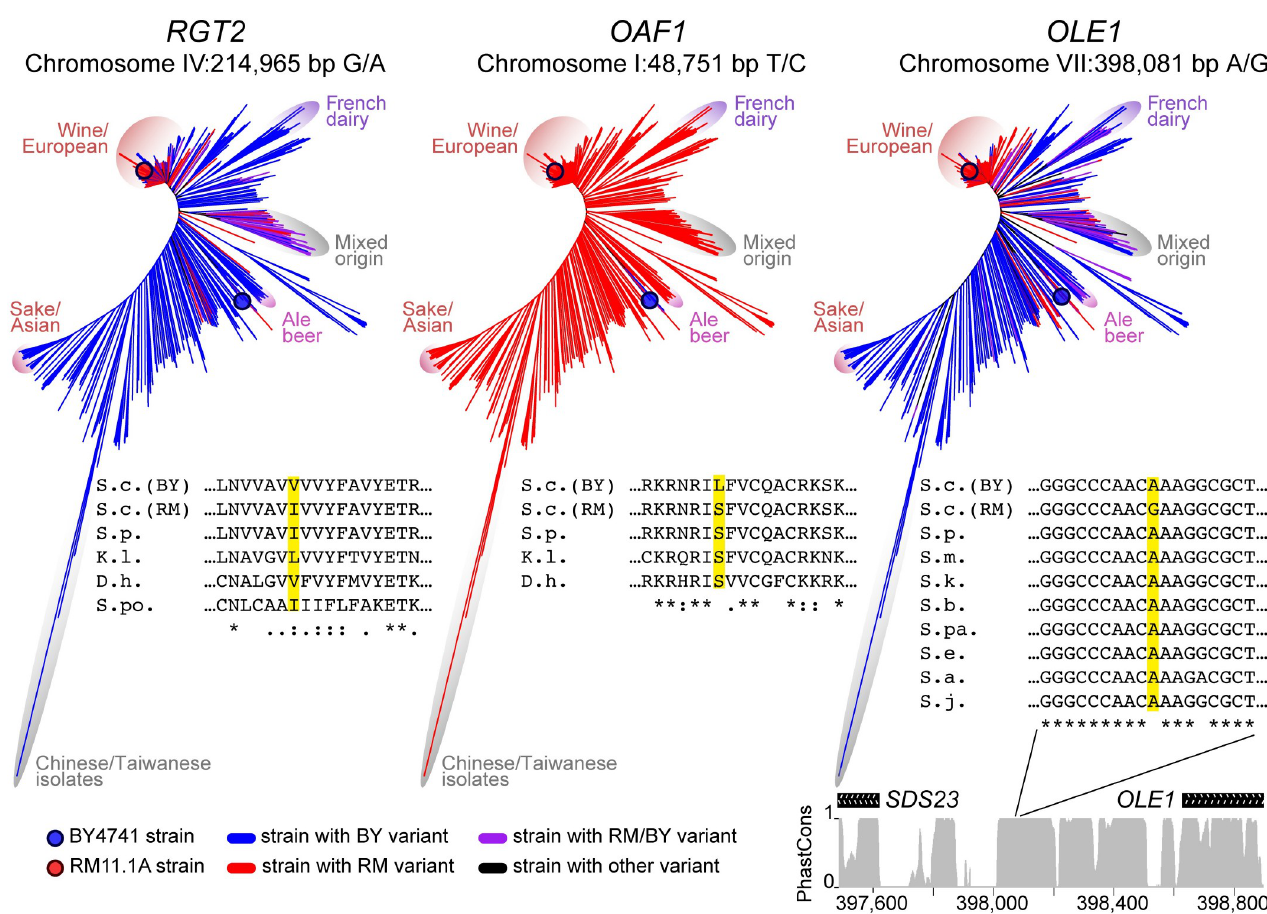
Fig 10. Population genetic features of the causal variants. Neighbor joining tree of the 1,011 S . cerevisiae strains sequenced in [67]. For each causal variant, the presence of the BY (blue), RM (red), BY and RM (purple), or other (black) allele is shown across the tree. For the OAF1 and RGT2 missense variants, amino-acid alignments with the indicated species are shown. For the intergenic FAR variant, we show nucleotide alignments as well as PhastCons conservation scores for the depicted SDS23 / OLE1 region from the UCSC Genome Browser. In alignments, species names are abbreviated: S.c., Saccharomyces cerevisiae ; S. p., S . paradoxus ; S.m., S . mikatae ; S.k., S . krudriavzevii ; S.b., S . bayanus ; S.pa., S . pastorianus ; S.e., S . eubaynus ; S.a., S . arboricola ; S.j., S . jurei ; K.c., Kluyveromyces lactis ; D.h., Debaryomyces hansenii ; S.po., Schizosaccharomyces pombe .